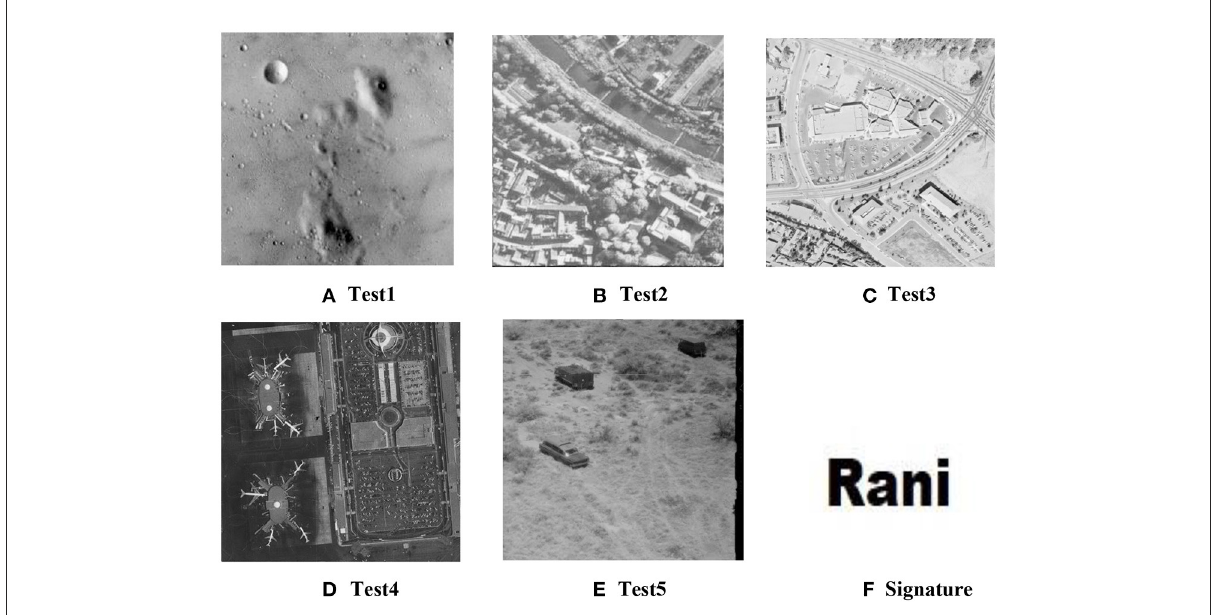
FIGURE4 Cover images (A–E) and signature watermark image (F)